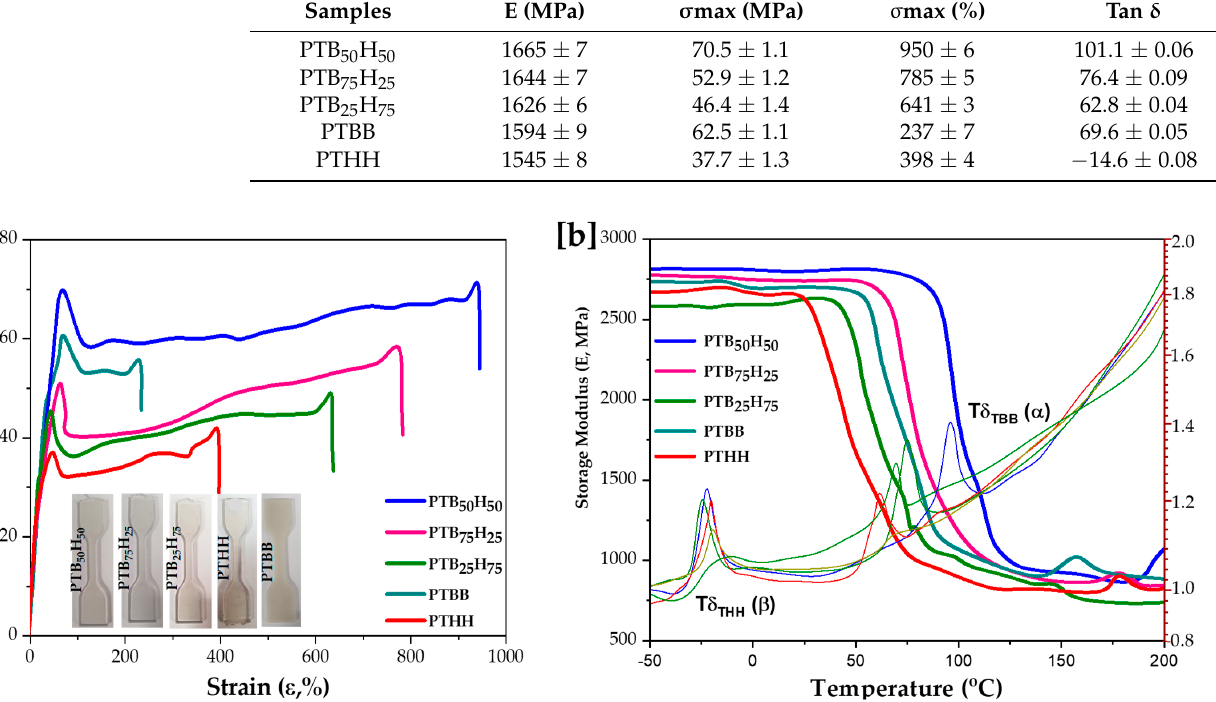
Figure 7. [ a ] Stress–strain curves and [ b ] DMTA for thepoly(1,4-bis(2-hydroxyethyl)benzene thio- phenedicarboxylate) (PTBB), poly(hexylene thiophenedicarboxylate) (PTHH), and poly(hexylene 2,5- thiophenedicarboxylate-co-bis(2-hydroxyethoxybenzene) copolyester